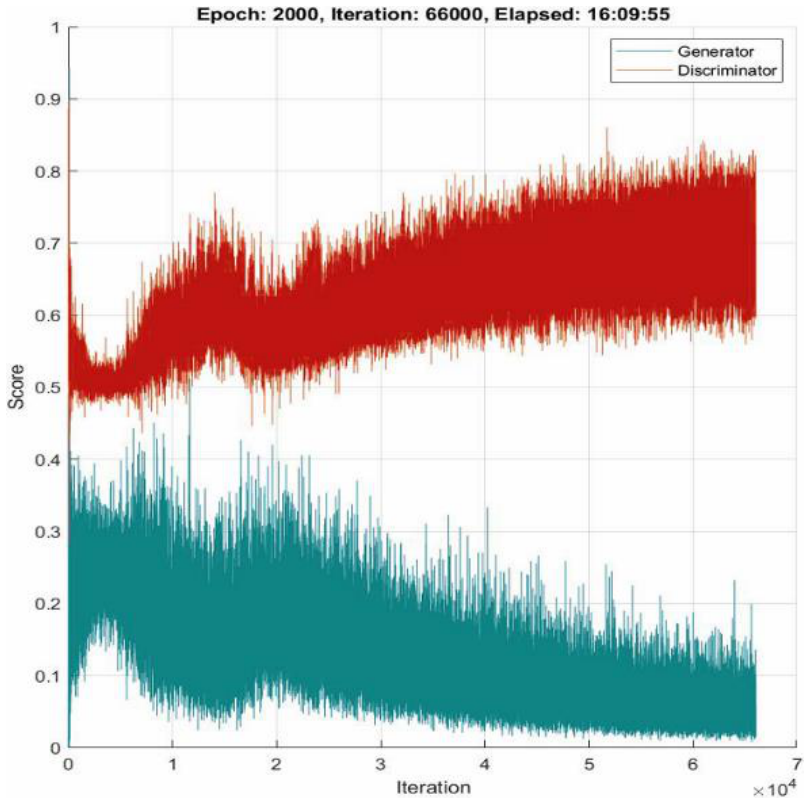
Figure 7. Generator and discriminator scores of the CGAN through the training process. The CGAN is trained on the whole dataset containing the three classes and then generates images for a given class (given label).